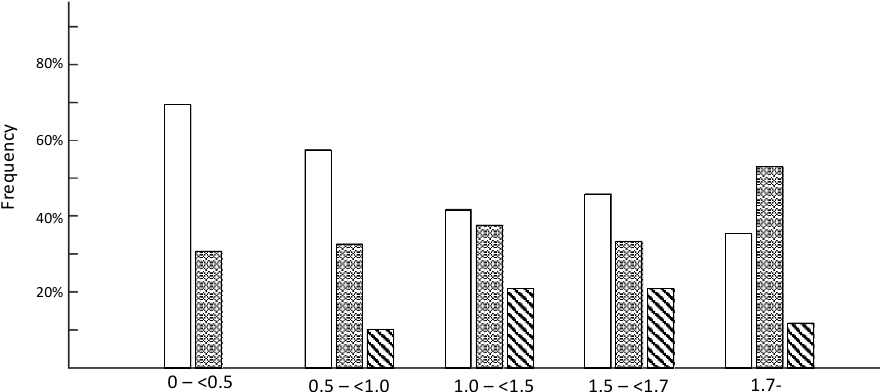
Figure 8. The patients were classified into five groups depending on M:A ratio, as described in Methods. We stratified the patients in each group using the EDX estimates according to the following rules: CMAP index less than −3 (white), CMAP index and SNAP index less than −3 (hatched gray) and others (diagonal black). This EDX stratification can estimate, using EDX data, the presence of myogenic or neurogenic involvement. The presence of myogenic findings according to EDX is seen to increase as the myosin concentration declines.